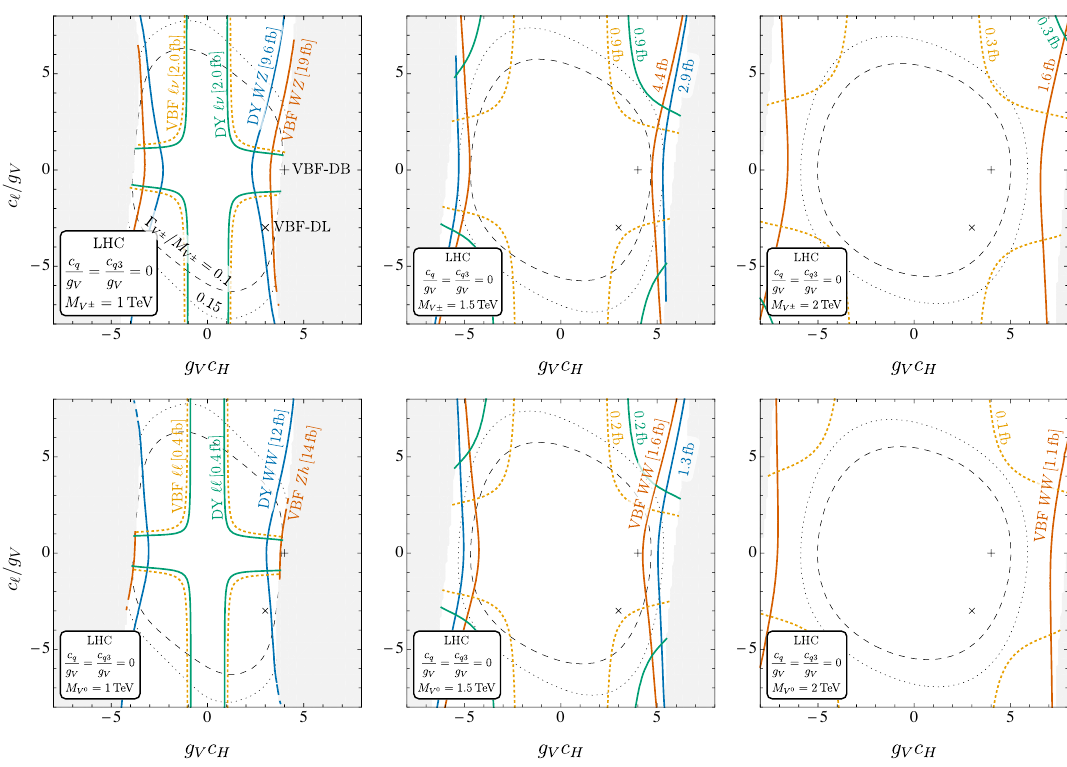
Figure 6 . Current limits in the g V c H − c ‘ /g V parameter plane for charged (top) and neutral (bottom) HVT resonances. Blue and red lines show the limits set by the most constraining DY and VBF searches in di-boson final states [34, 35, 43]. The solid green and dotted yellow lines shows the most constraining lepton-neutrino [50, 51] (top) and di-lepton limit [48, 49] (bottom) for DY (solid green) and VBF (dotted yellow) assuming the same sensitivity as for DY. The dashed and dotted black lines show contours of constant Γ = 0 . 1 and 0 . 15 . The + and × symbols indicate the tot /M V VBF-DB and VBF-DL benchmark parameter points, respectively. The grey regions are theoretically excluded in the simplified